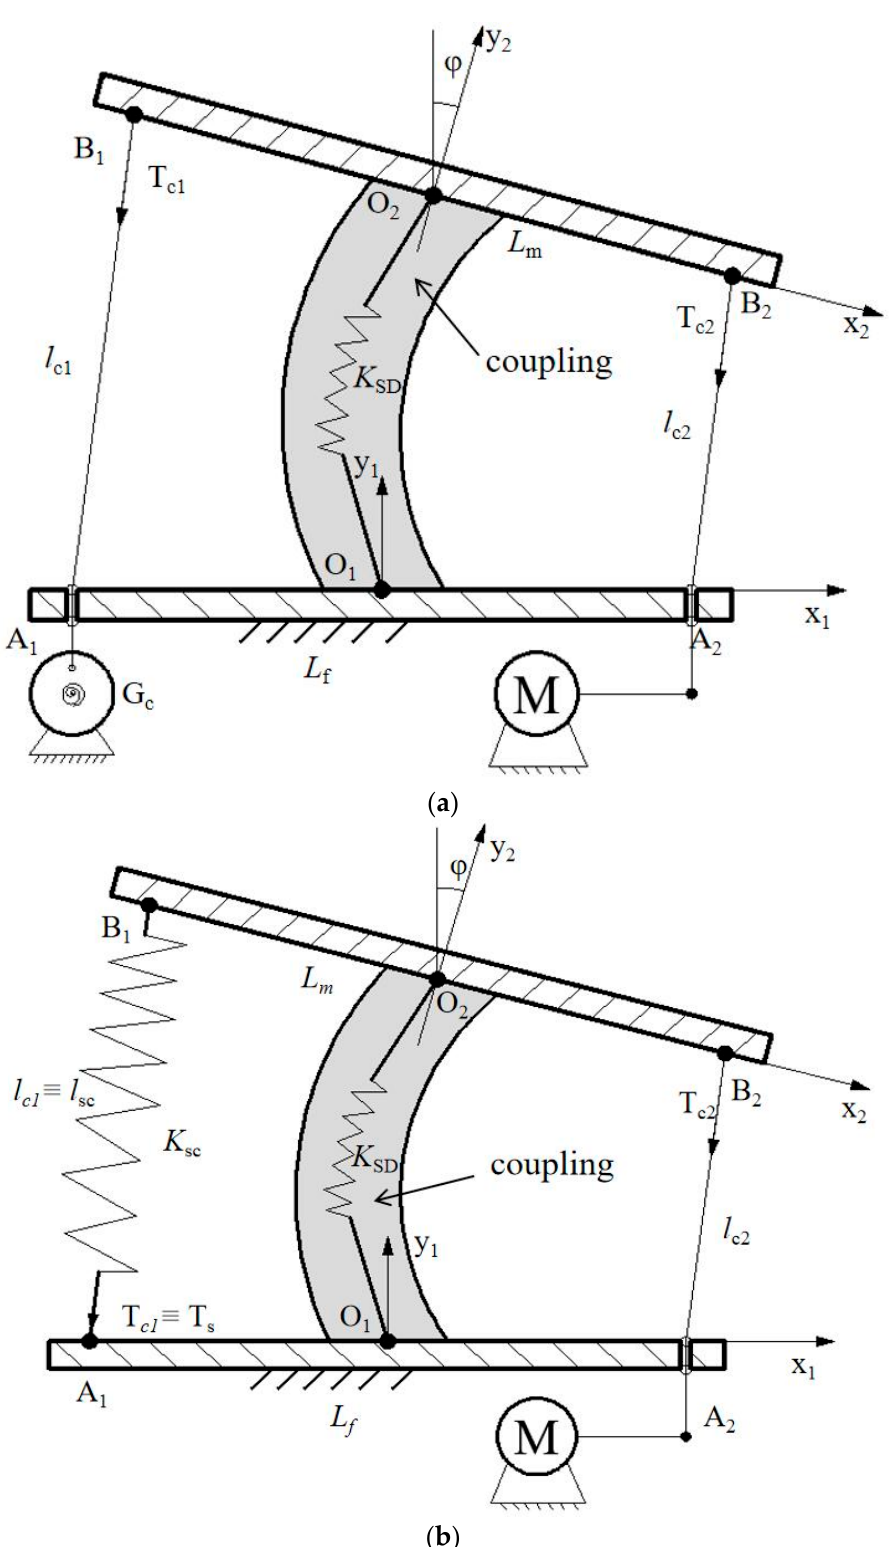
Figure 15. Conceptual design for a new vertebra-disc unit: ( a ) with torsion spring; ( b ) with linear spring.